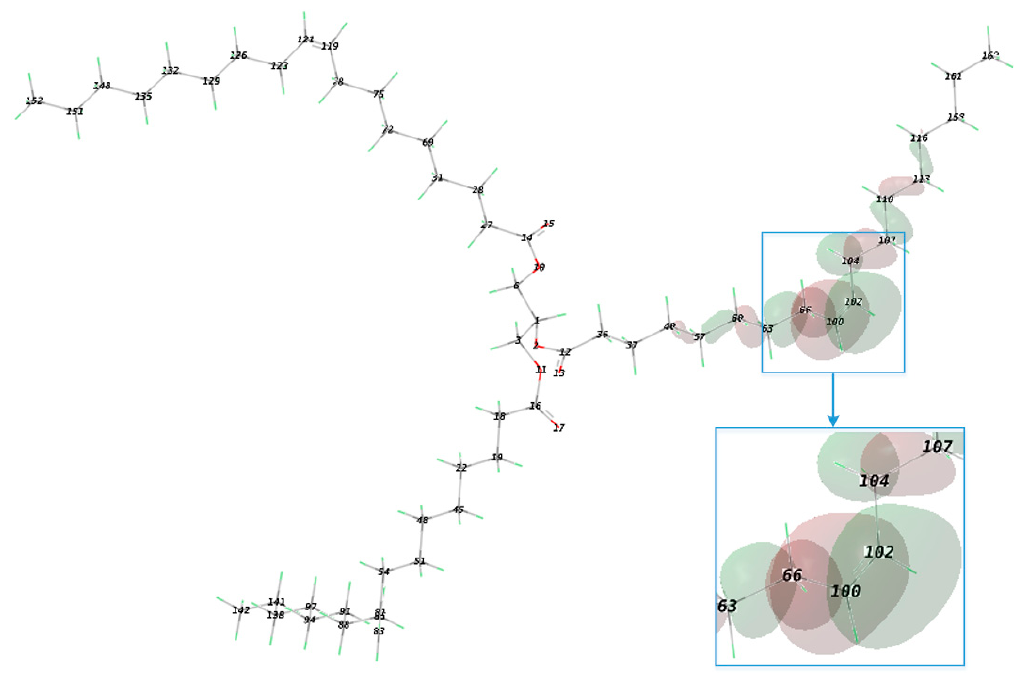
Figure 4. Isosurface of HOMO of triolein molecule.